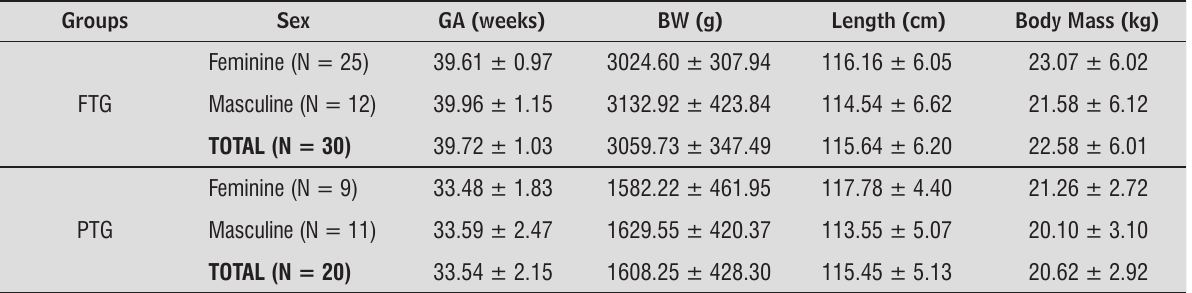
Table 1 - Characteristics of the study participants (average value ± standard deviation) Groups